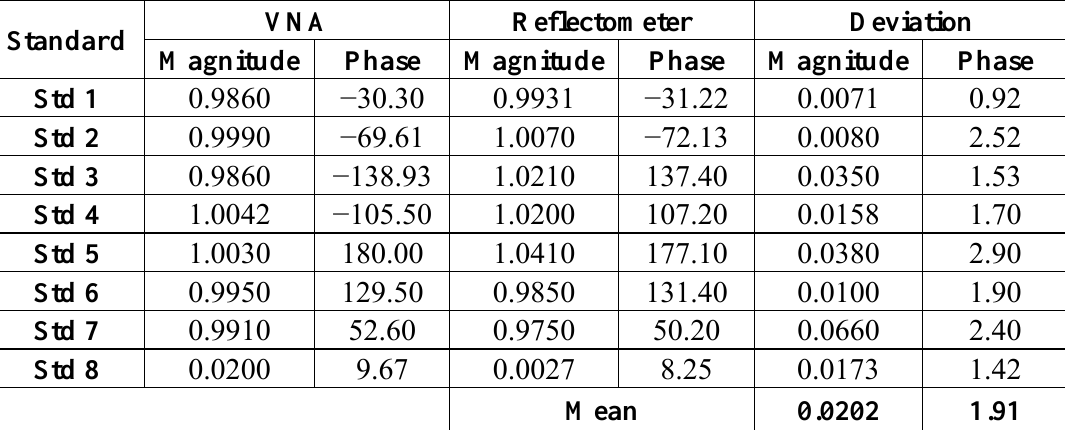
Table 1. Magnitude and phase of reflection coefficient measured using reflectometer and commercial VNA.